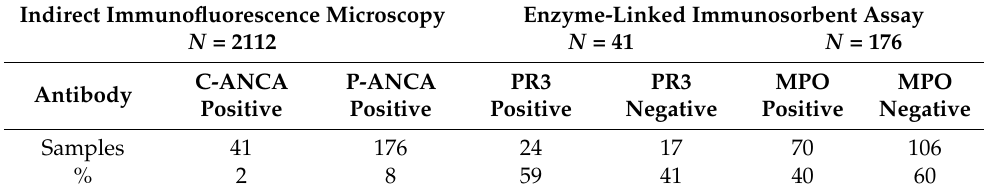
Table 4. ANCA, PR3 and MPO Abs in patient serum samples tested by IIF and ELISA. 2112 samples were tested in IIF and 217 ANCA-positive samples (C-ANCA and (P-ANCA) were tested in ELISA. C-ANCA positive samples were tested for PR3 Abs, while P-ANCA positive samples were tested for MPO